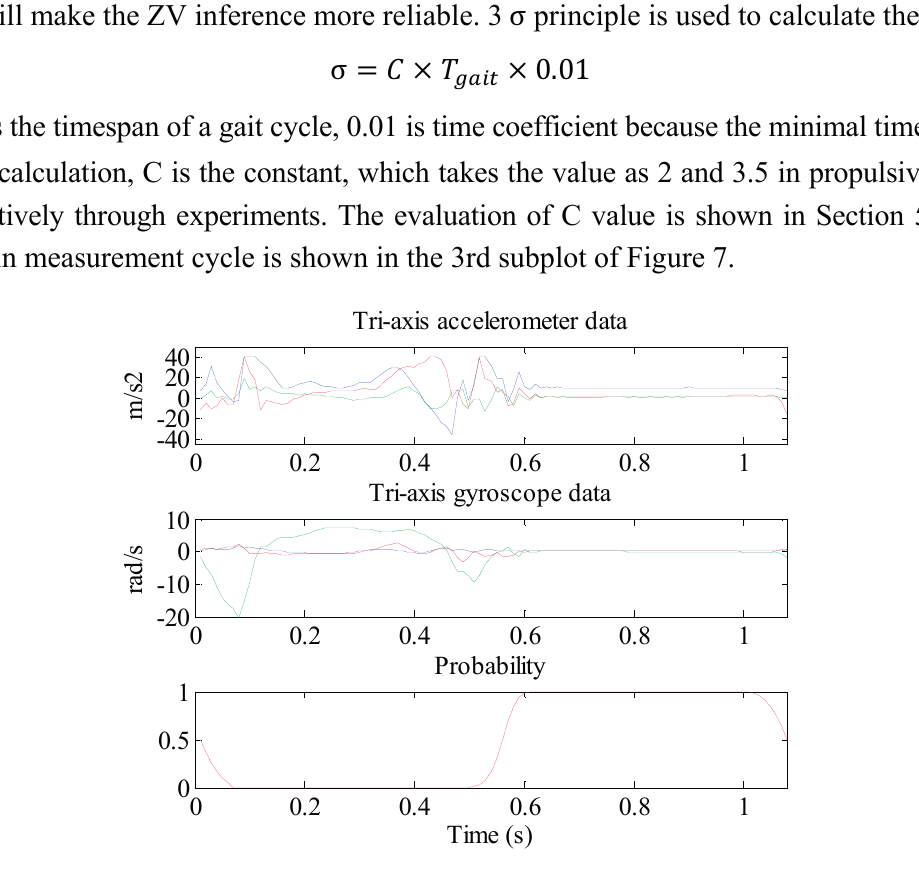
Figure 7. Measurements of accelerometer and gyroscope in one gait cycle, and CPD in measurement